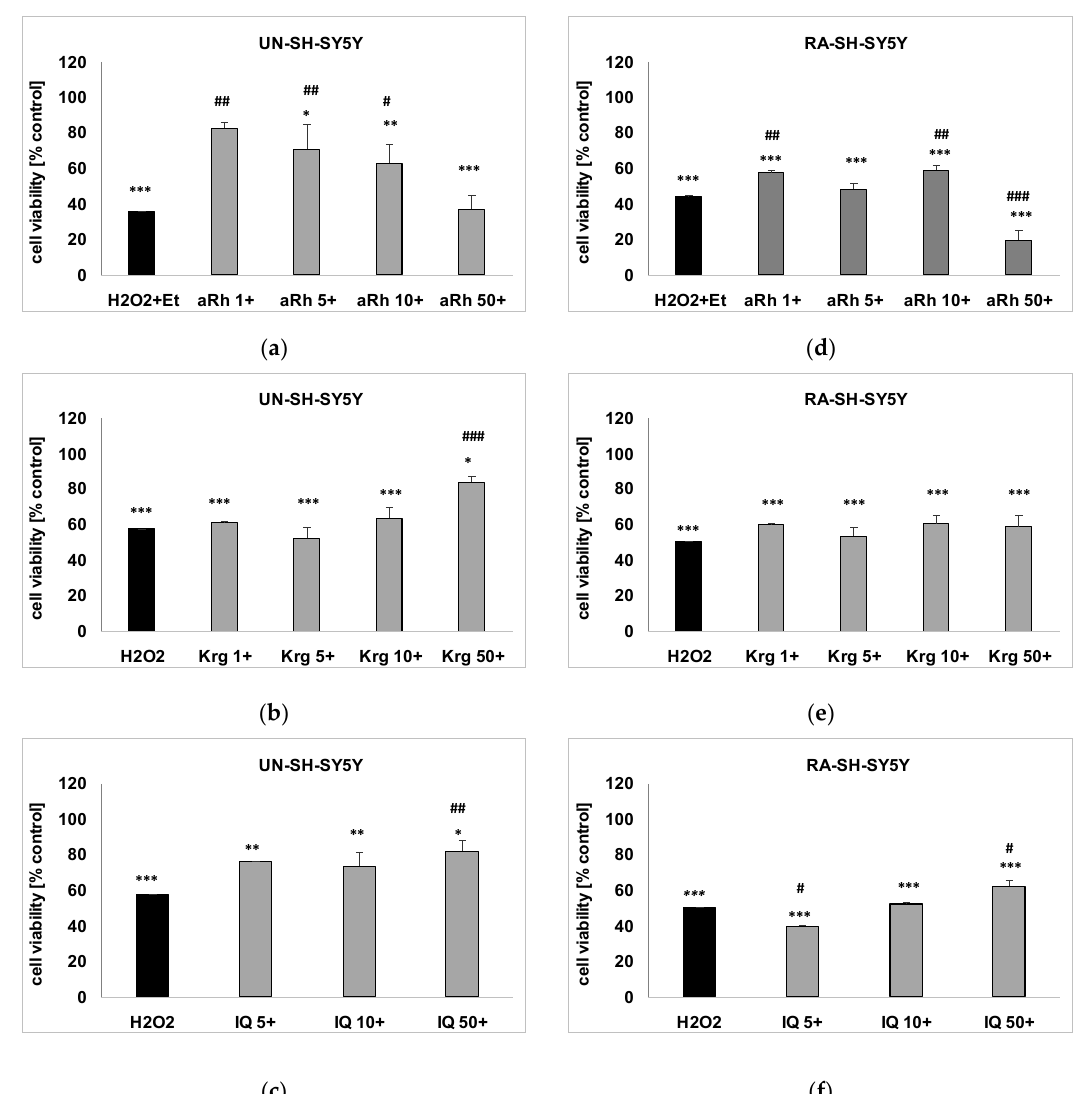
Figure 5. The protective effects of flavonols against hydrogen peroxide (H 2 O 2 )-evoked cell damage in UN- ( a – c ) and RA-SH-SY5Y ( d – f ) cells. The cells were pre-treated for 30 min with α-rhamnoisorobin (aRh, 1–50 µM; a , d ), kaempferitrin (Krg, 1–50 µM; b , e ) and isoquercitrin (IQ, 5–50 µM; c , f ) followed by 24 h exposure to H 2 O 2 (0.375 and 0.5 mM for UN- and RA-SH-SY5Y, respectively). Cell viability was measured by WST-1 assay and the data were normalized to the vehicle-treated cells and presented as the mean ± SEM. The data were analyzed by one-way ANOVA. * p < 0.05, ** p < 0.01, *** p < 0.001 vs. the vehicle-treated cells; # p < 0.05, ## p < 0.01, ### p < 0.001 vs. the H 2 O 2 -treated cells.